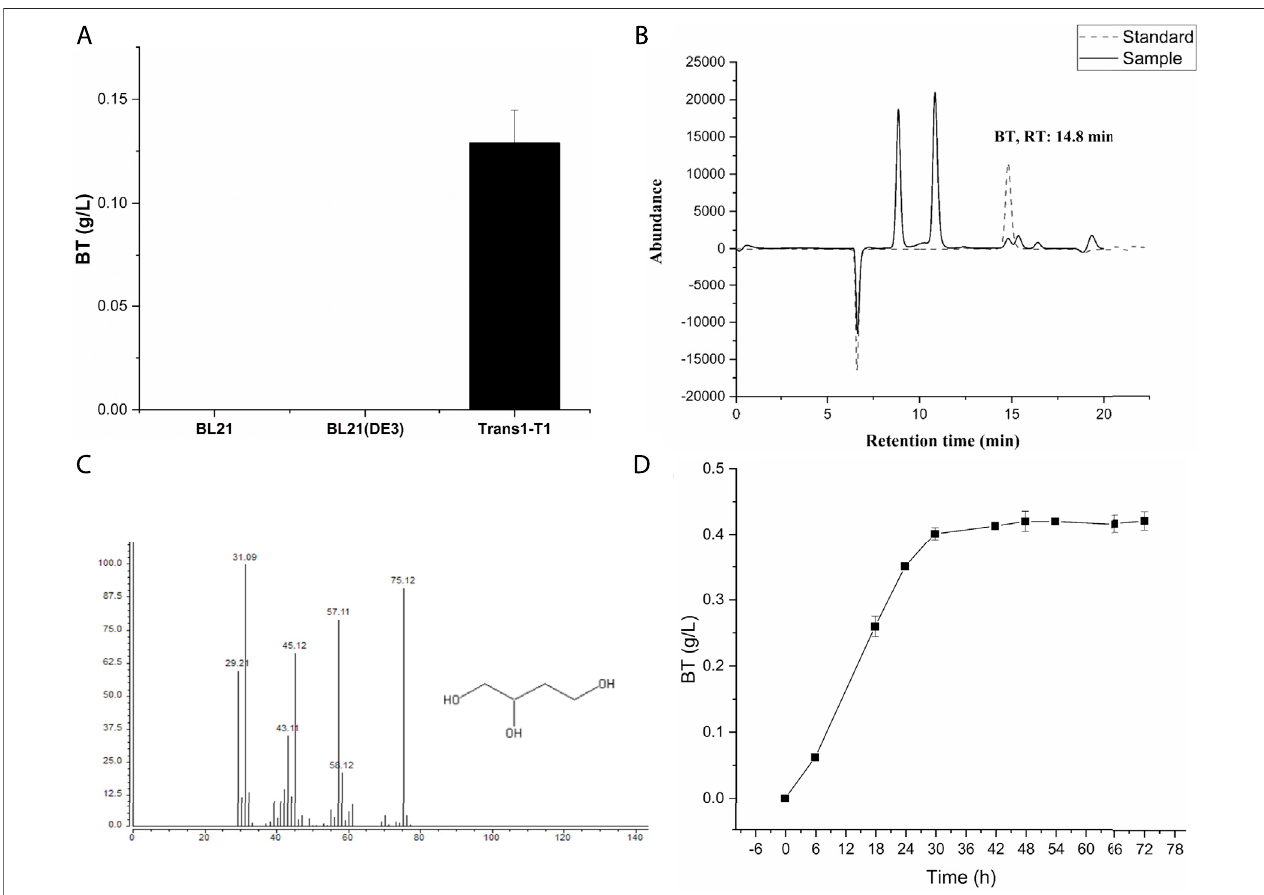
FIGURE 2 | HPLC and GC-MS analysis for proof of the novel synthetic pathway for the production of BT from D -arabinose. (A) BT1 represents the strain E. coli Trans1-T1/pTrc99a-MdlC-AraDH, pCWJ-AraD-AdhP; BL21-1 represents the strain E. coli BL21/pTrc99a-MdlC-AraDH, pCWJ-AraD-AdhP; BL21 (DE3)-1 represents the strain E. coli BL21 (DE3)/pTrc99a-MdlC-AraDH, pCWJ-AraD-AdhP. The bioconversion process was carried out at 33 ° C on a rotatory shaker (200 rpm). (B) HPLC analysis for proof of the novel synthetic pathway to produce BT from D -arabinose. The solid line represents the abundance of standard BT and the dashed line represents the abundance of the sample. Retention time of BT was 14.08 min. (C) GC-MS analysis of the BT produced by strain BT1. (D) The time-course of the bio- conversionprocesscatalyzedbythestrainBT1.Bio-catalysisof D -arabinosetoBTwasconductedina100-mlErlenmeyer fl askwhichcontainsa20-mlreactionmixture. OD 600nm of the reaction mixture was 60. The concentration of D -arabinose was 20 g/L. The titer of Mg 2+ was 10 mM. The reaction mixture was incubated at 33 ° C on a rotatory shaker (200 rpm). Error bars represent SD ( n = 3).